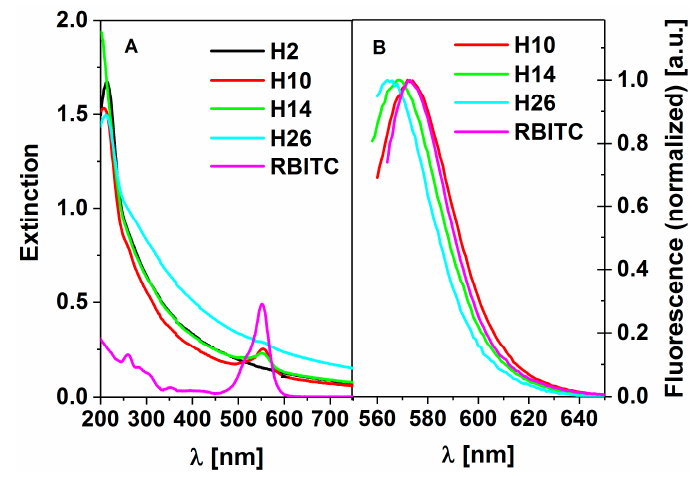
Figure 10. Extinction ( A ) and normalized fluorescence ( B ) spectra of H2, H10, H14, H26, and RBITC samples; no fluorescence for H2 was observed ( B ).